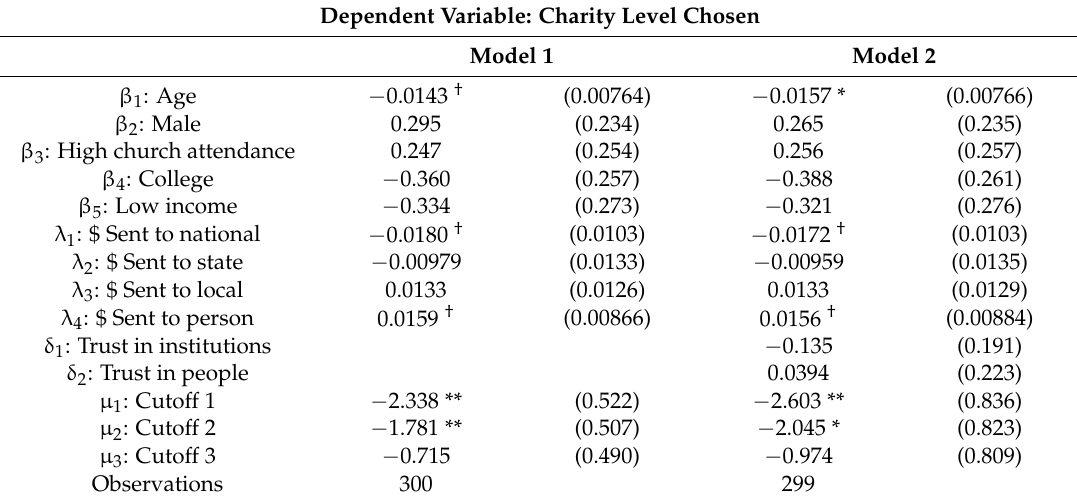
Table 7. Ordered logit results for the selected dictator game. 1